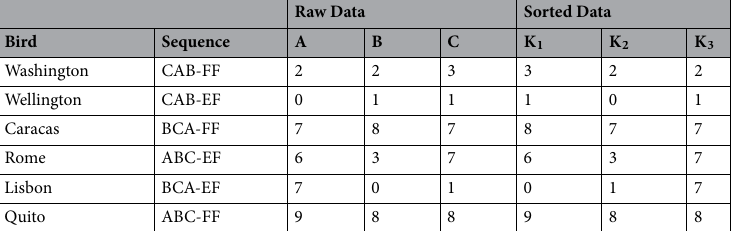
Raw Data Sorted